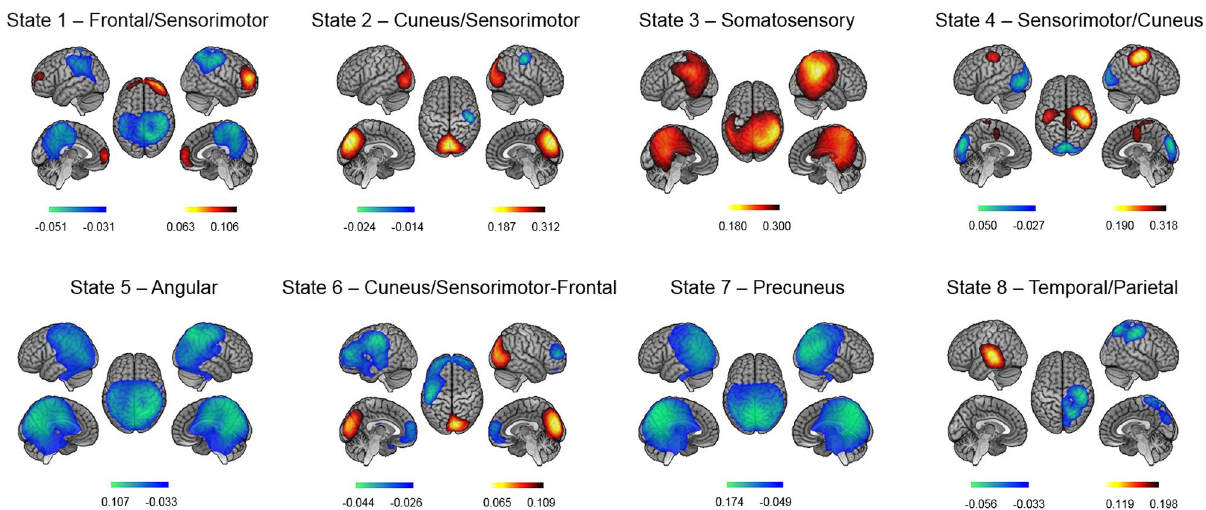
Figure 2. Spatial topographies of HMM transient states computed over pre- and post-learning RS sessions. Red/blue scales indicate positive/negative correlation values between the envelope and the state activation/ inactivation time course (i.e., increased/decreased power during one state visit). For visualization purpose, the maps are thresholded between 60 and 100% of the maximum absolute of the partial correlation values. The maps were obtained using MATLAB R2016a, The MathWorks, Inc, https:// www. mathw orks. com/ and MRIcrone version 1.0.20190902, 2019, Chris Rorden, https:// www. nitrc.